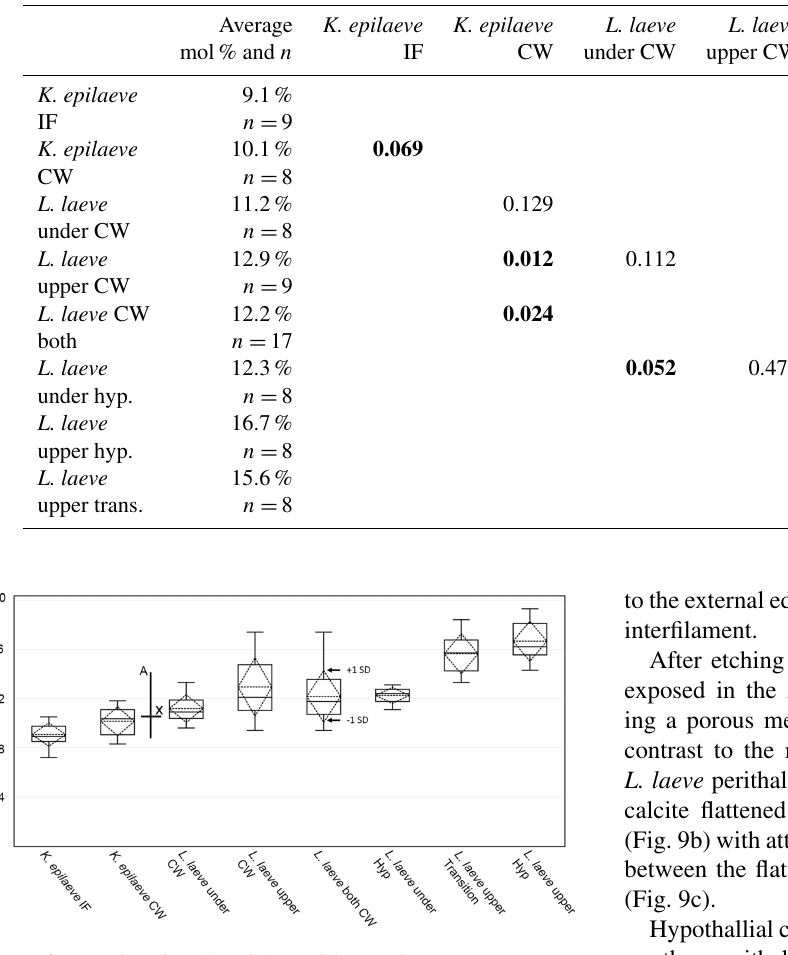
Figure 6. Box plot of EDSmol% MgCO 3 results. Boxes represent the second and third quartiles. The lower and upper bars are the minimum and maximum values (excluding an outlier for L. laeve under cell wall). The solid middle line within the box is the median value and the dash middle line the average. The dashed diamond box represents one standard deviation. The drawn-on cross repre- sents the XRDmol% (X) and the seasonal range (a) of mol% for the Arctic Bay–Kingitok–Quirpon dataset in Fig.